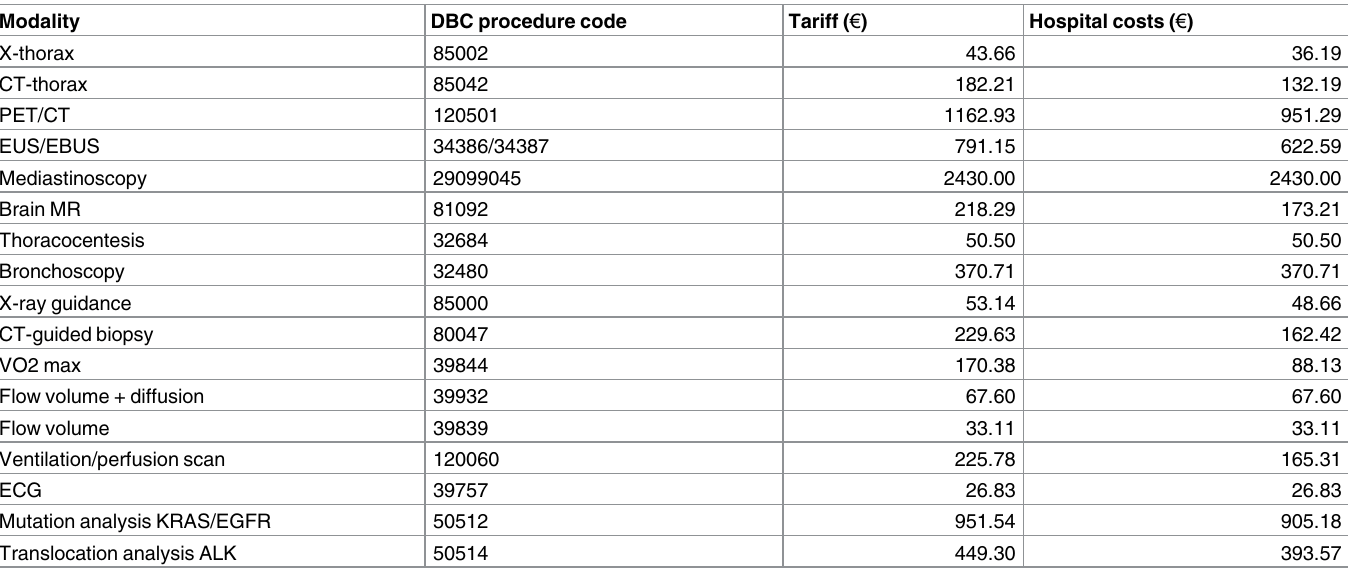
Table 3. Procedure and test tariffs